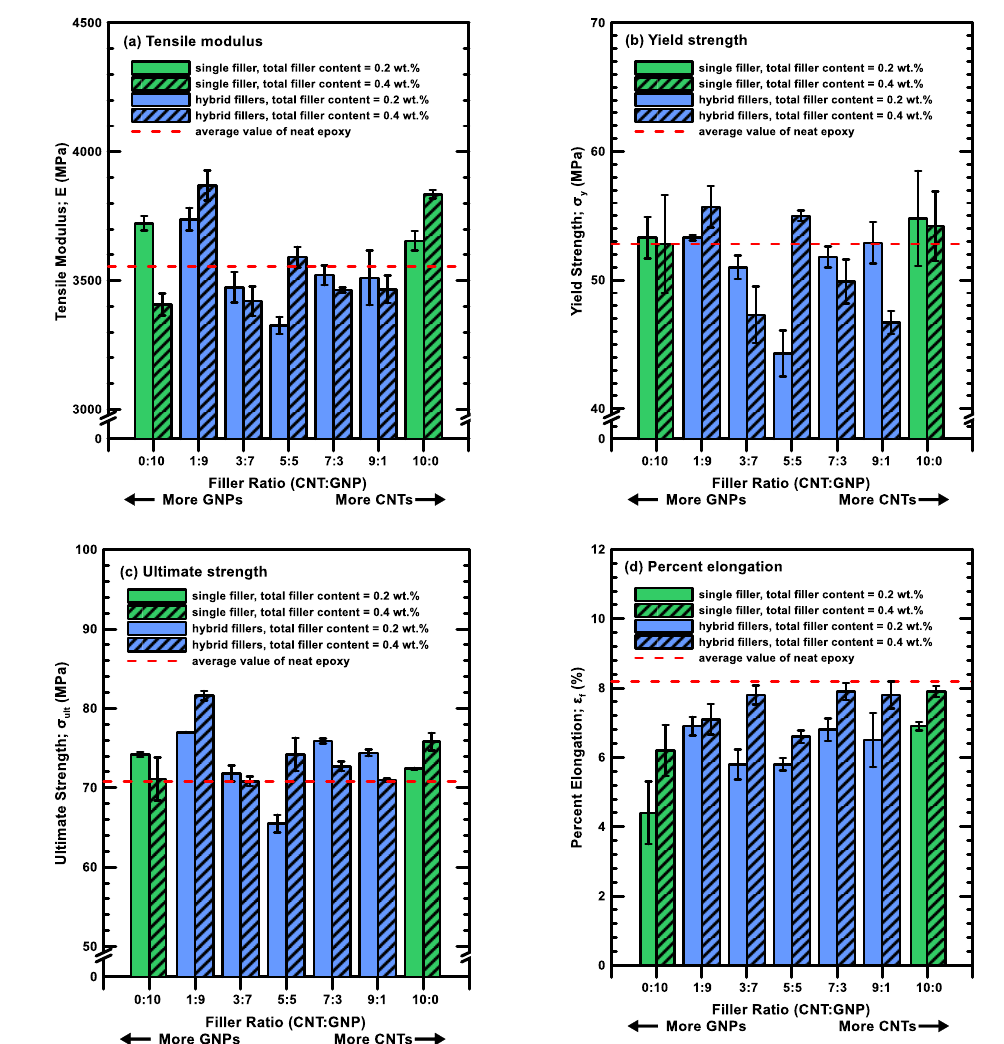
Figure 4. Monotonic properties for the nanocomposites with various filler ratios: ( a ) tensile modulus E , ( b ) yield strength σ y , ( c ) ultimate strength σ ult , and ( d ) percent elongation ε f .